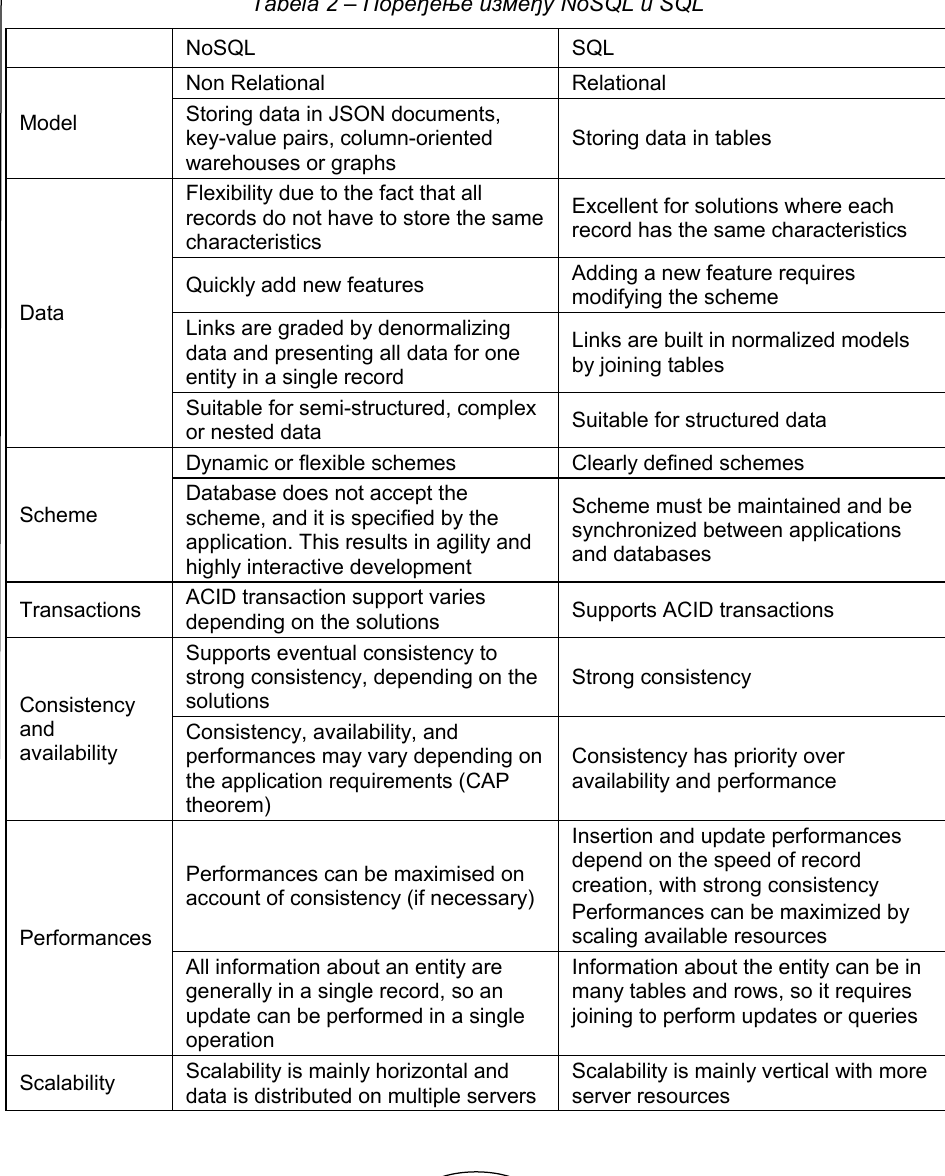
Table 2 – Comparison between NoSQL and